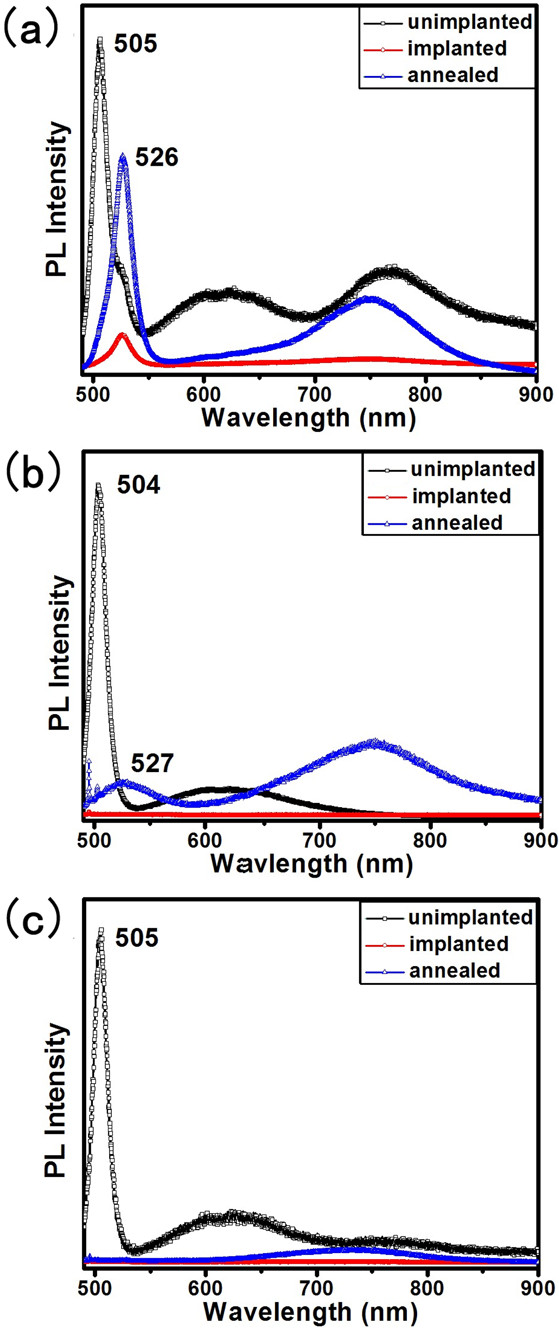
PL emission spectrum of CdS nanobelts. They are implanted by N+ ions with doses of (a) 5 × 1015, (b) 1 × 1016 and (c) 5 × 1016 ions/cm2.